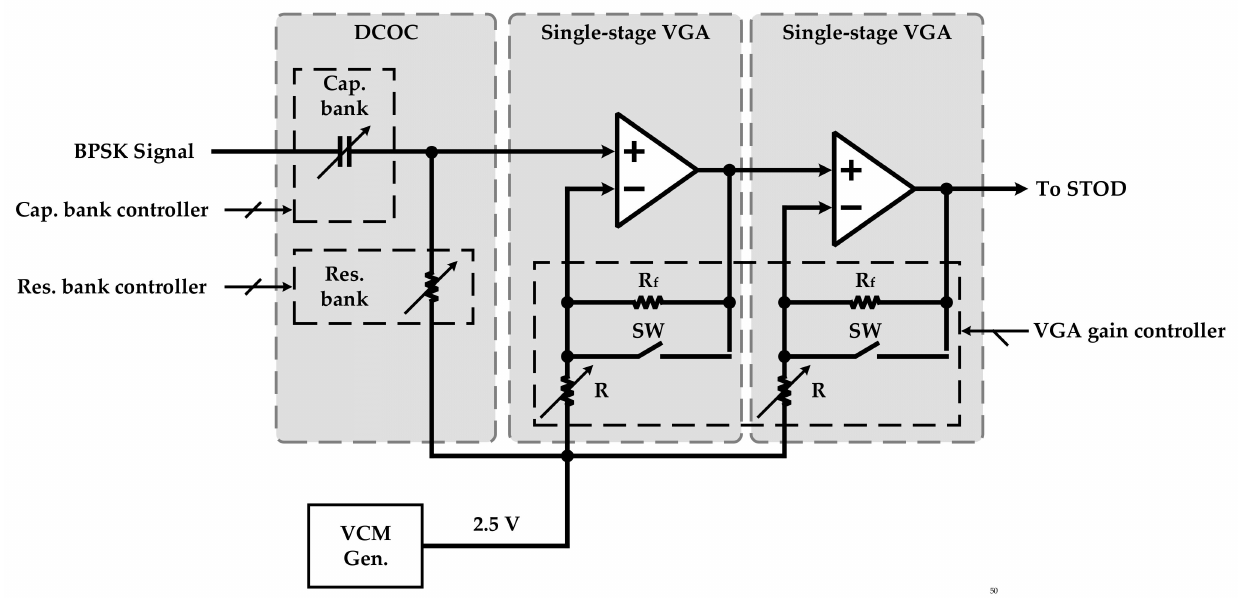
Figure 6. Block diagram of the DCOC and the cascaded